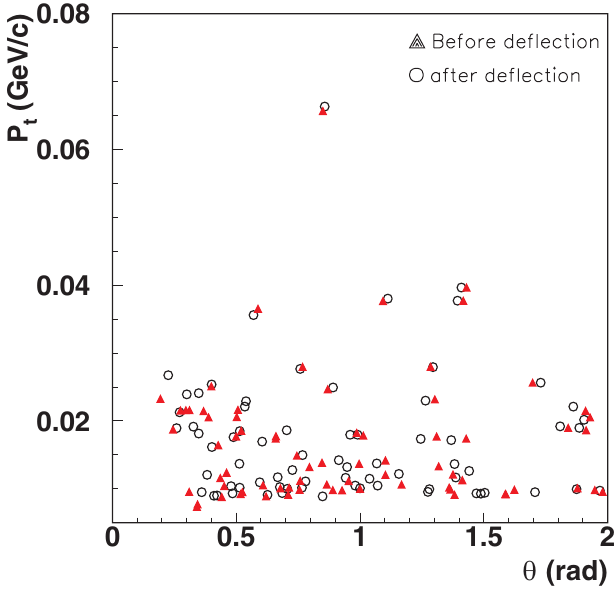
FIG. 8. (Color) Distribution of P IPC processes reaching the VD, before electromagnetic deflec- tions (triangles) and after (circles).